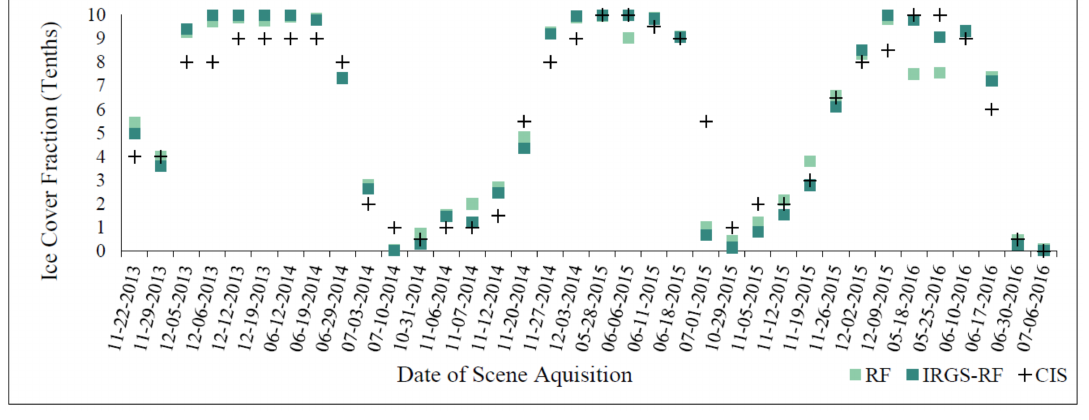
Figure 8. Ice cover fraction for GBL generated with IRGS-RF with comparison to the reported fraction from CIS. The date of each SAR scene in this study is shown with the corresponding fraction; however the date of reported ice cover from CIS may vary from this date by ± 3